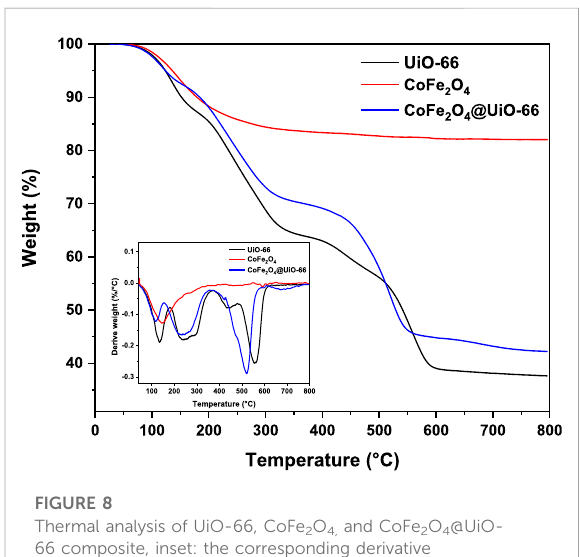
FIGURE 8 Thermal analysis of UiO-66, CoFe 2 O 4, and CoFe 2 O 4 @UiO- 66 composite, inset: the corresponding derivative thermogravimetric (DTG)